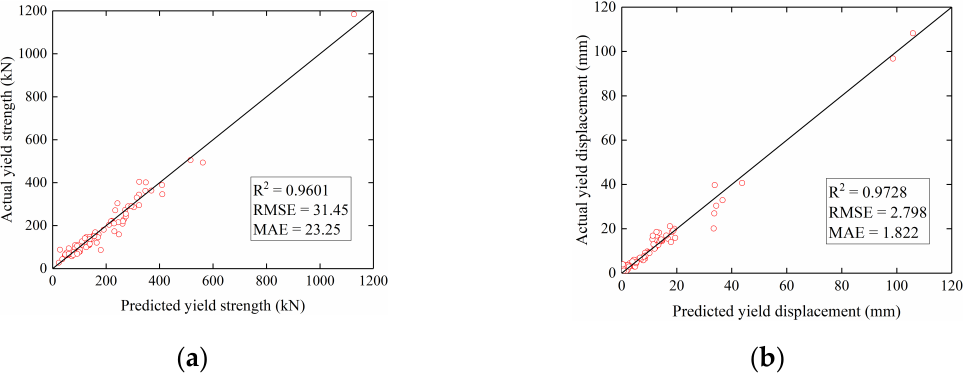
Figure 6. Testing result of PSO-LSSVM (number of samples = 77): ( a ) Yield strength; ( b ) Yield